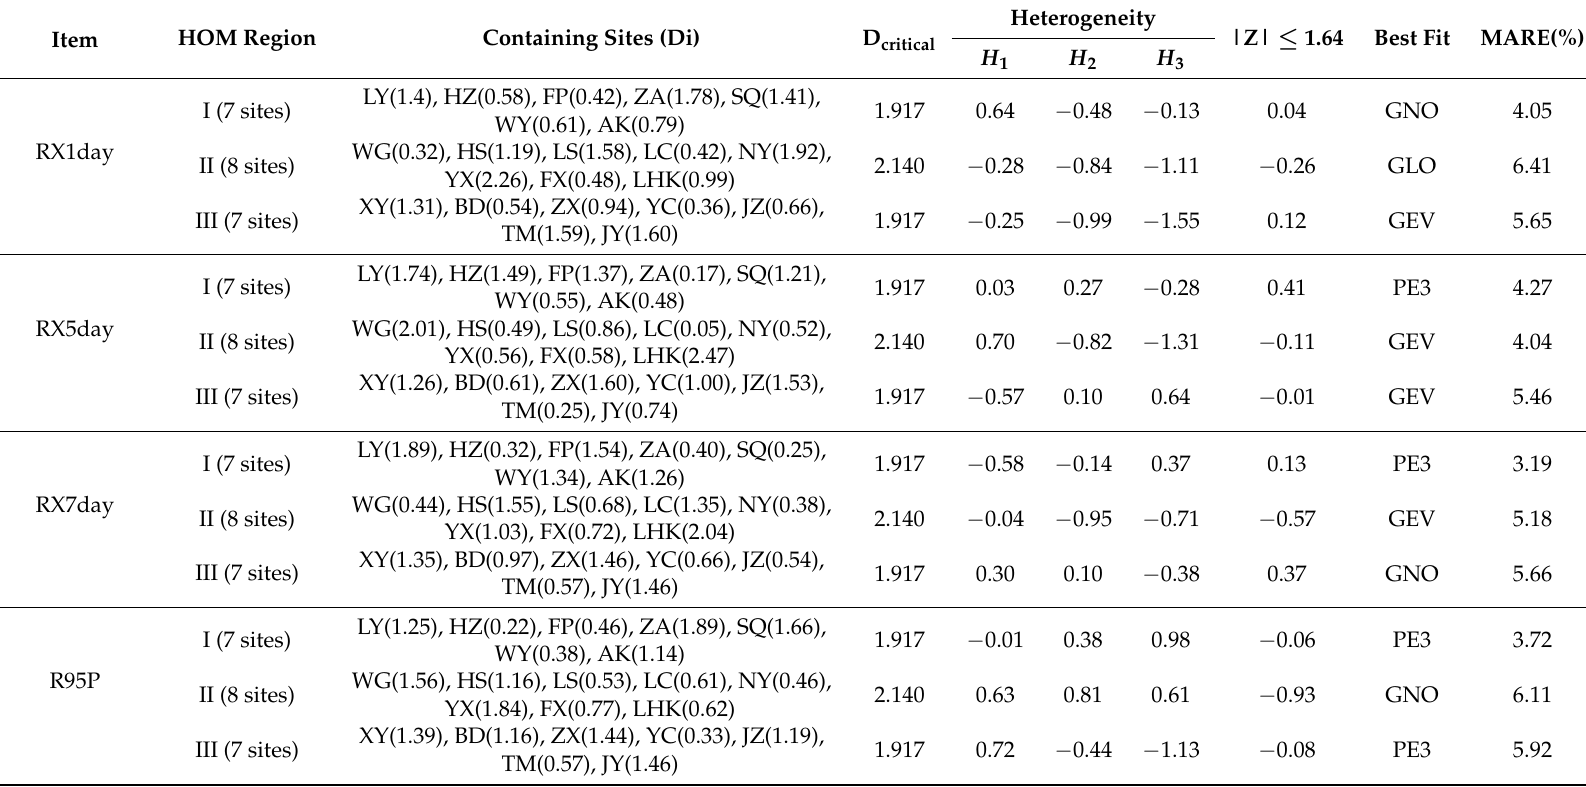
Table 3. Results of discordance, heterogeneity, goodness-of-fit tests and MARE for 24 stations in the Hanjiang River Basin